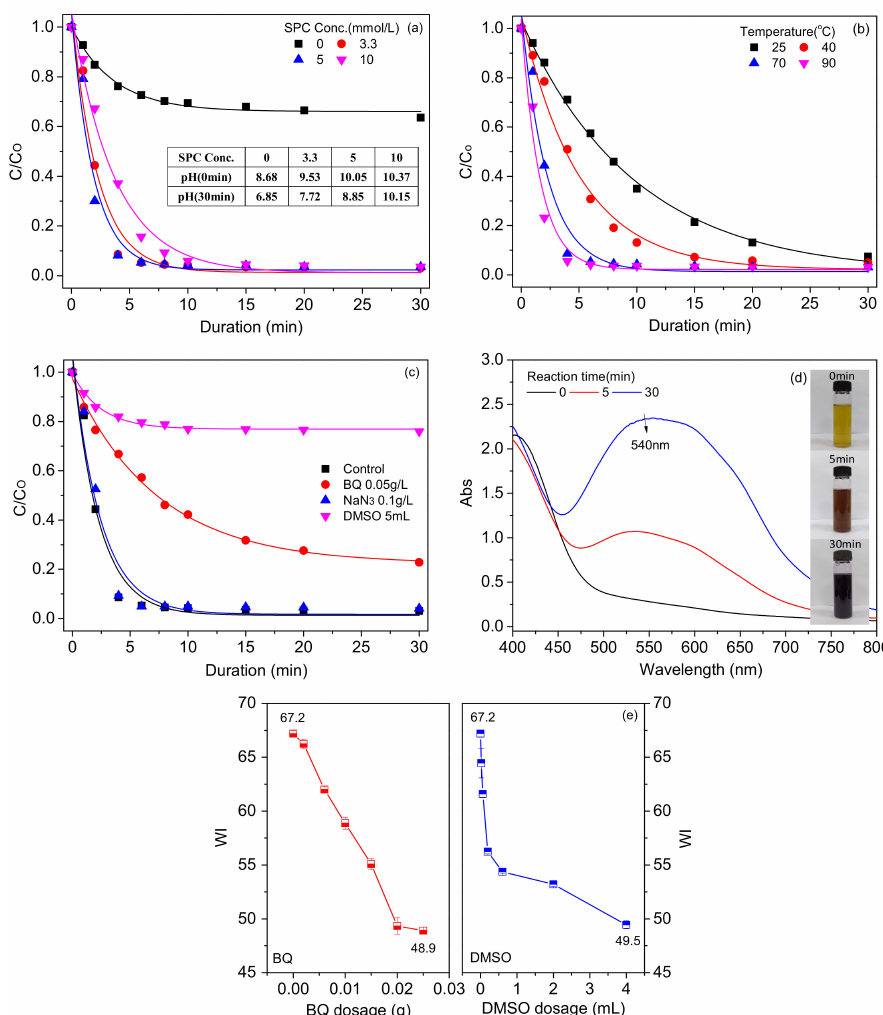
Figure 5. Effect of the ( a ) SPC concentration and ( b ) temperature on the degradation of the morin with the TAED/SPC system; ( c ) influences of DMSO, BQ and NaN 3 on the morin degradation in the homo- geneous TAED/SPC system; ( d ) UV-Vis spectra of the NBT that reacted with the TAED/SPC; ( e ) effect of the concentration of DMSO and BQ on the WI of the cotton fabric bleached by the TAED/SPC system. Conditions: morin 120 µ mol/L ( a – c ), NaOH 1 mmol/L ( a – c ), TAED 5 mmol/L ( a – d ), 70 ◦ C ( a , c , d ), SPC 3.3 mmol/L ( b – d ) and NBT 0.2 g/L ( d